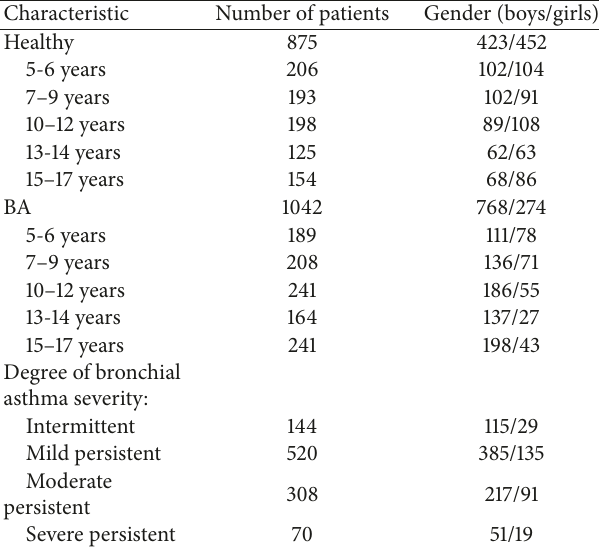
Table 1: Clinical profile of